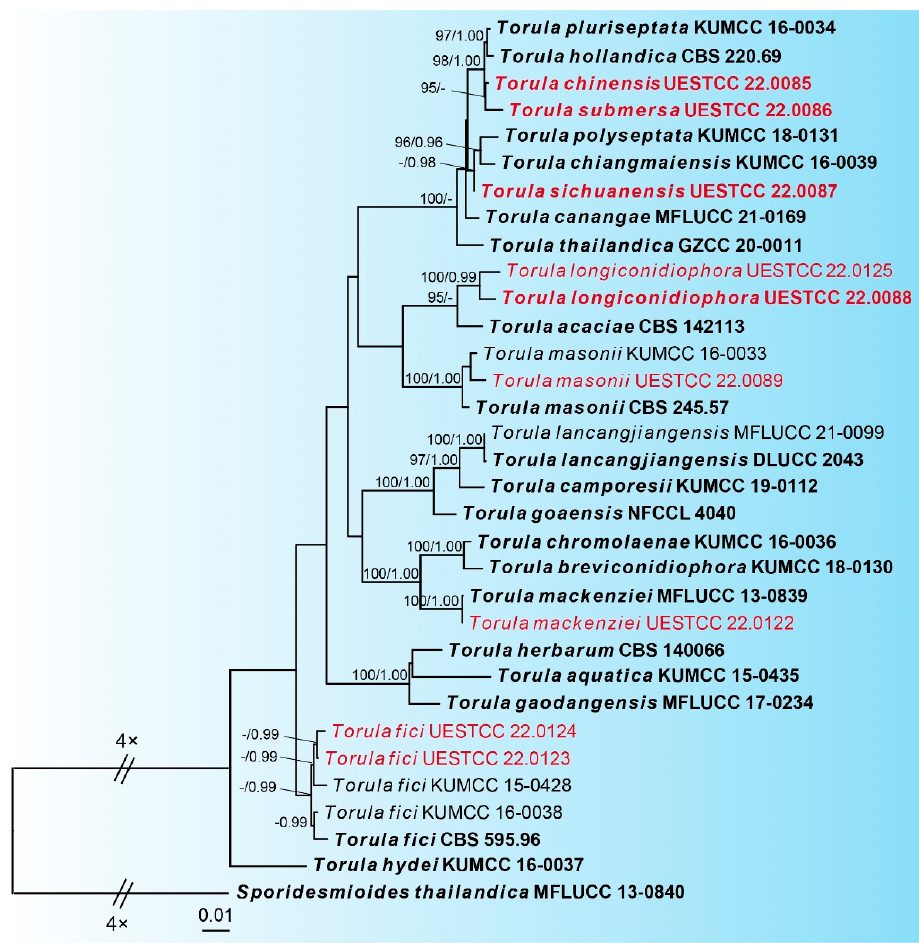
Figure 1. Phylogram of the best ML tree of species of Torula based on a combined dataset of LSU, ITS, SSU, TEF, and RPB2. Novel isolates are indicated in red. Type isolates are in bold. The ML ultrafast bootstrap values/Bayesian PP greater than 95%/0.95 are indicated at the respective nodes. The tree is rooted with Sporidesmioides thailandica (MFLUCC 13-0840).